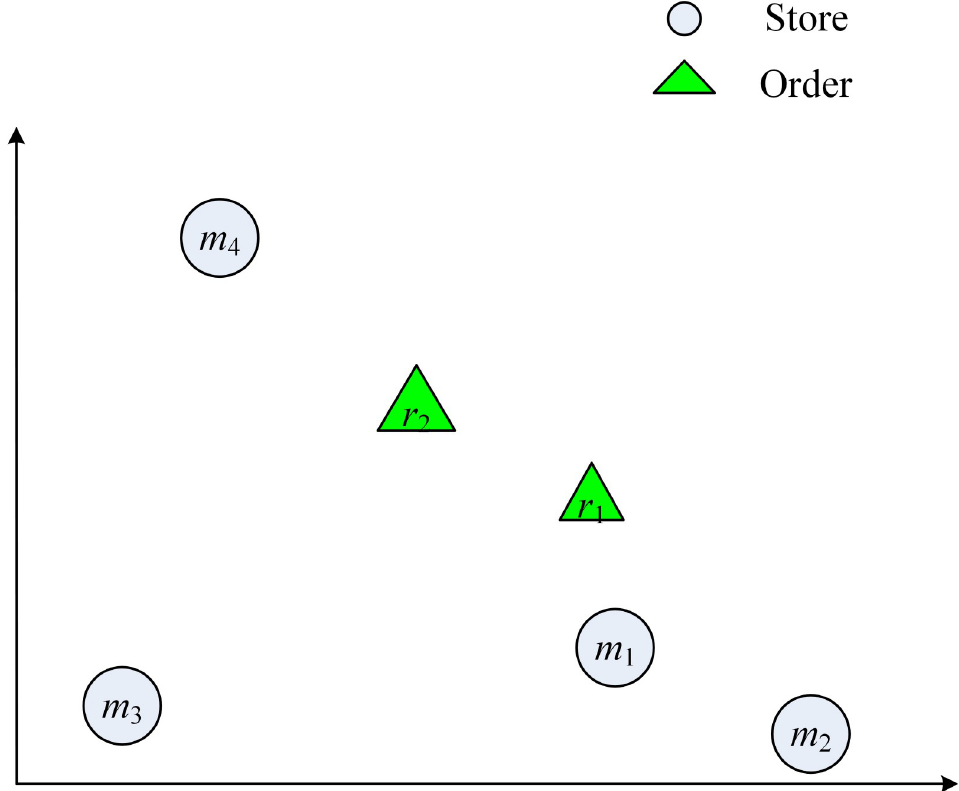
Fig 1. The location of each store and order. Fig 1 is the example diagram of the distribution of stores and orders in the example.